Question: Express in one sentence what the figure is showing.
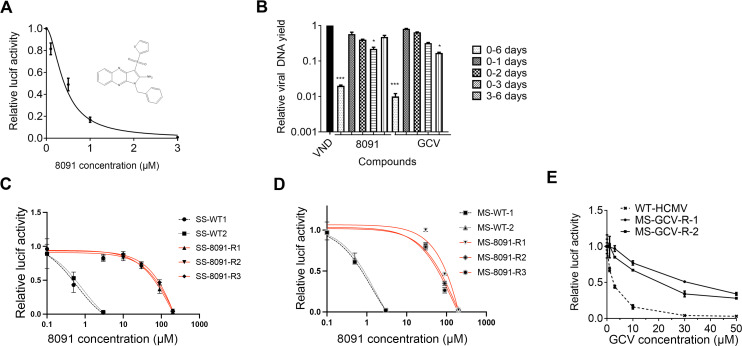
Answer: Anti-HCMV activity of MLS8091 against WT and drug-resistant mutants. ( A ) Human foreskin fibroblasts (HFFs) were infected with HCMV Towne (multiplicity of infection [MOI] of 1 PFU/cell) and treated with the indicated concentrations of MLS8091 (chemical structure). Luciferase activity was measured in cell lysates at 96 h post-infection (hpi). ( B ) HFFs were infected with HCMV Towne (MOI 1) and treated with either MLS8091 (3 µM) or GCV (5 µM) for the indicated time points. Viral DNA was isolated from cell supernatants at day 6 and quantified by US17 real-time PCR. Conditions included continuous compound exposure through day 6, compound removal at days 1, 2, or 3, or delayed compound addition at day 3 with removal at day 6. Statistical significance is compared with the virus-no-drug (VND) conditions. ( C ) HFFs were infected with pp28-luciferase wild-type (MOI 0.1) or MLS8091-resistant mutants generated by a single-step (SS) protocol and treated with the indicated concentrations of MLS8091. Luciferase activity was measured in cell lysates at 72 hpi. R1, 2, and 3 represent individual viral strains from SS selection. Each strain was sequenced after 10 drug-free passages following the initial SS selection and plaque purification. Data for R1, R2, and R3 refer to the stocks collected after 10 drug-free passages. ( D ) HFFs were infected with wild-type or MLS8091-resistant mutants generated by a multi-step (MS) protocol and treated with the indicated concentrations of MLS8091. Luciferase activity was measured in cell lysates at 72 hpi. R1, 2, and 3 represent individual viral strains from MS selection. Each strain was sequenced after 10 drug-free passages following the initial MS selection and plaque purification. Data for R1, R2, and R3 refer to the stocks collected after 10 drug-free passages. ( E ) HFFs were infected (MOI 0.1) with wild-type or GCV-resistant mutants generated by the MS protocol, and pp28 luciferase was measured at 72 hpi.